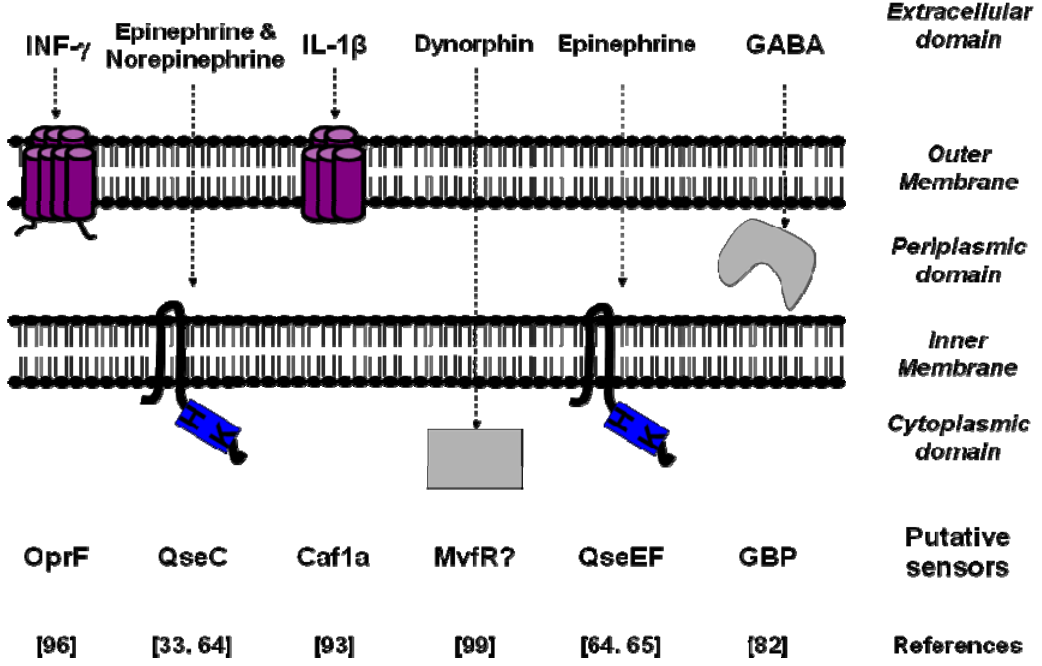
The Gram-negative cell envelope is composed of the periplasmic space confined between the outer membrane and the inner membrane. The cell envelop separates the extracellular domain which contains eukaryotic ligands (top of the figure) and the cytoplasmic domain of the bacteria. The name of the putative sensors and the references associated to their characterization are indicated on the bottom of the figure. GABA: gamma aminobutyric